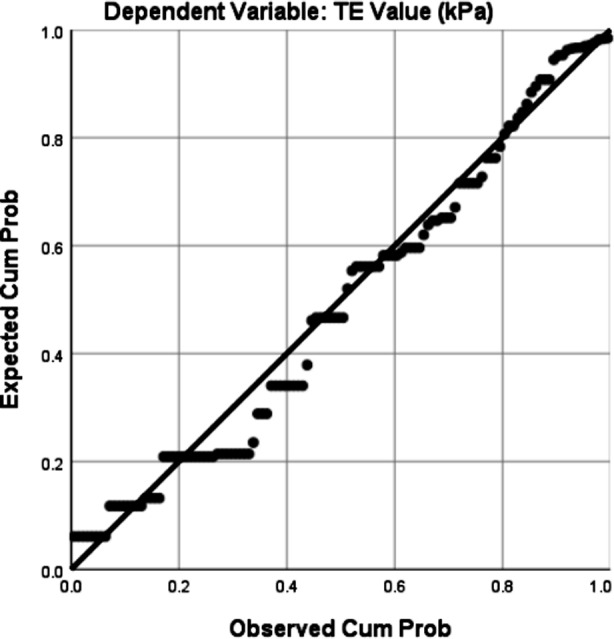
Normal P-P Plot of Regression Standardized Residual.